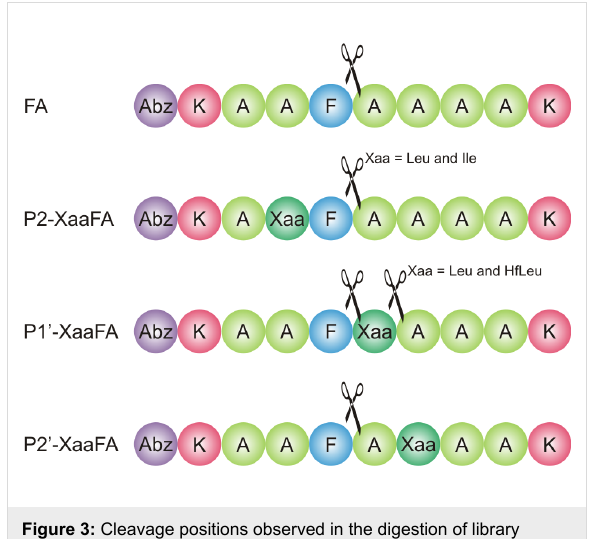
Figure 3: Cleavage positions observed in the digestion of library peptides with α